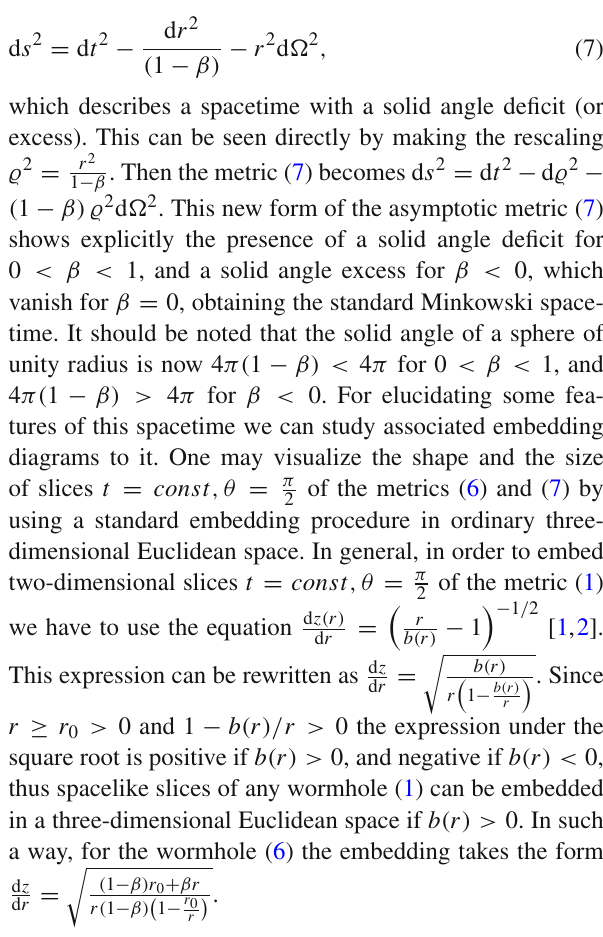
+ β r ≥ 1, for r > r 0 0 , and